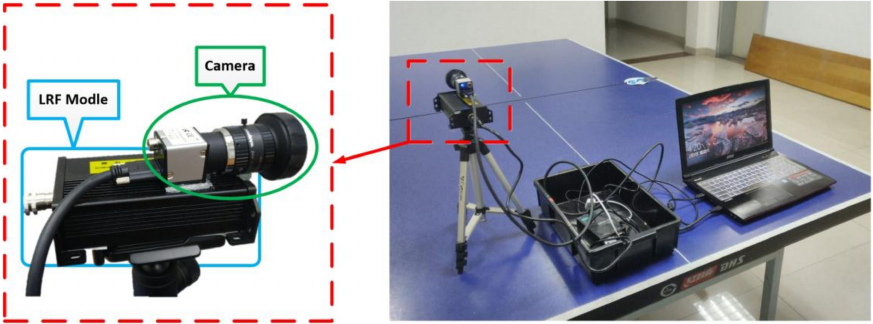
Figure 7. Measurement system combining 1D LRF and